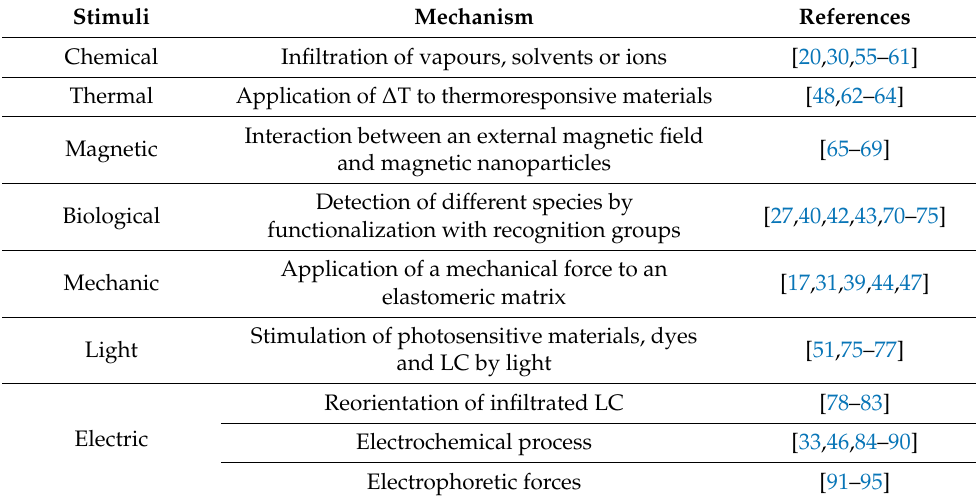
Table 2. Summary of main stimuli used for tunable photonic